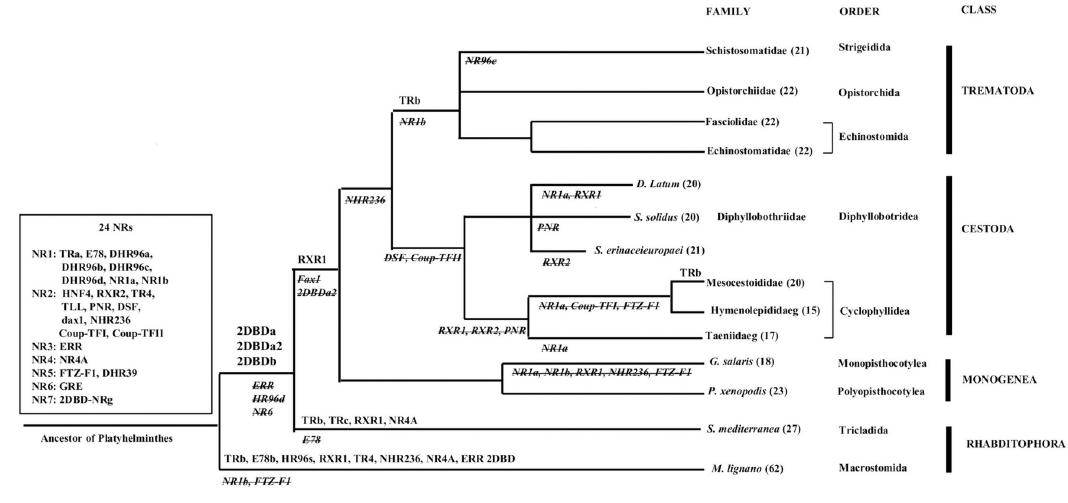
Fig 6. Summary of NR gene gain and loss in